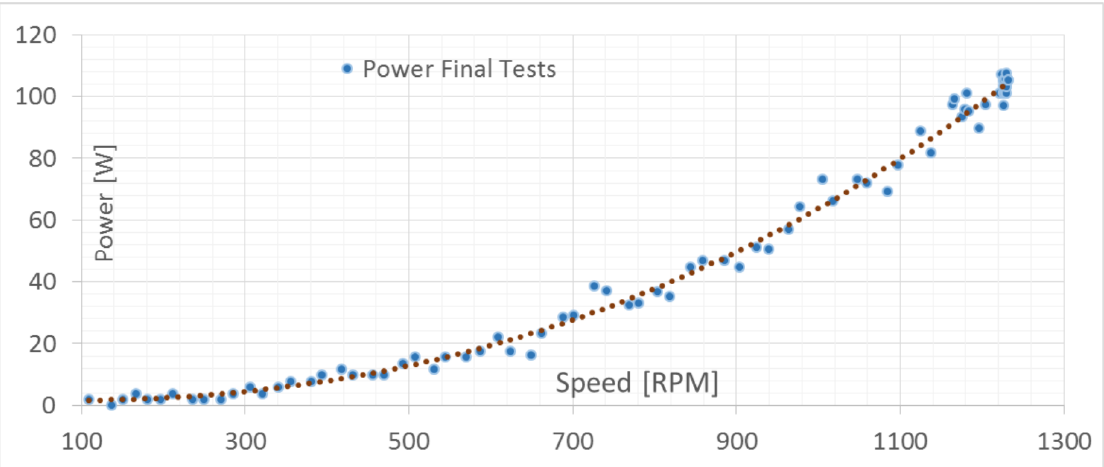
Figure 18. Results of bollard pull thrust tests: power vs. motor RPM.